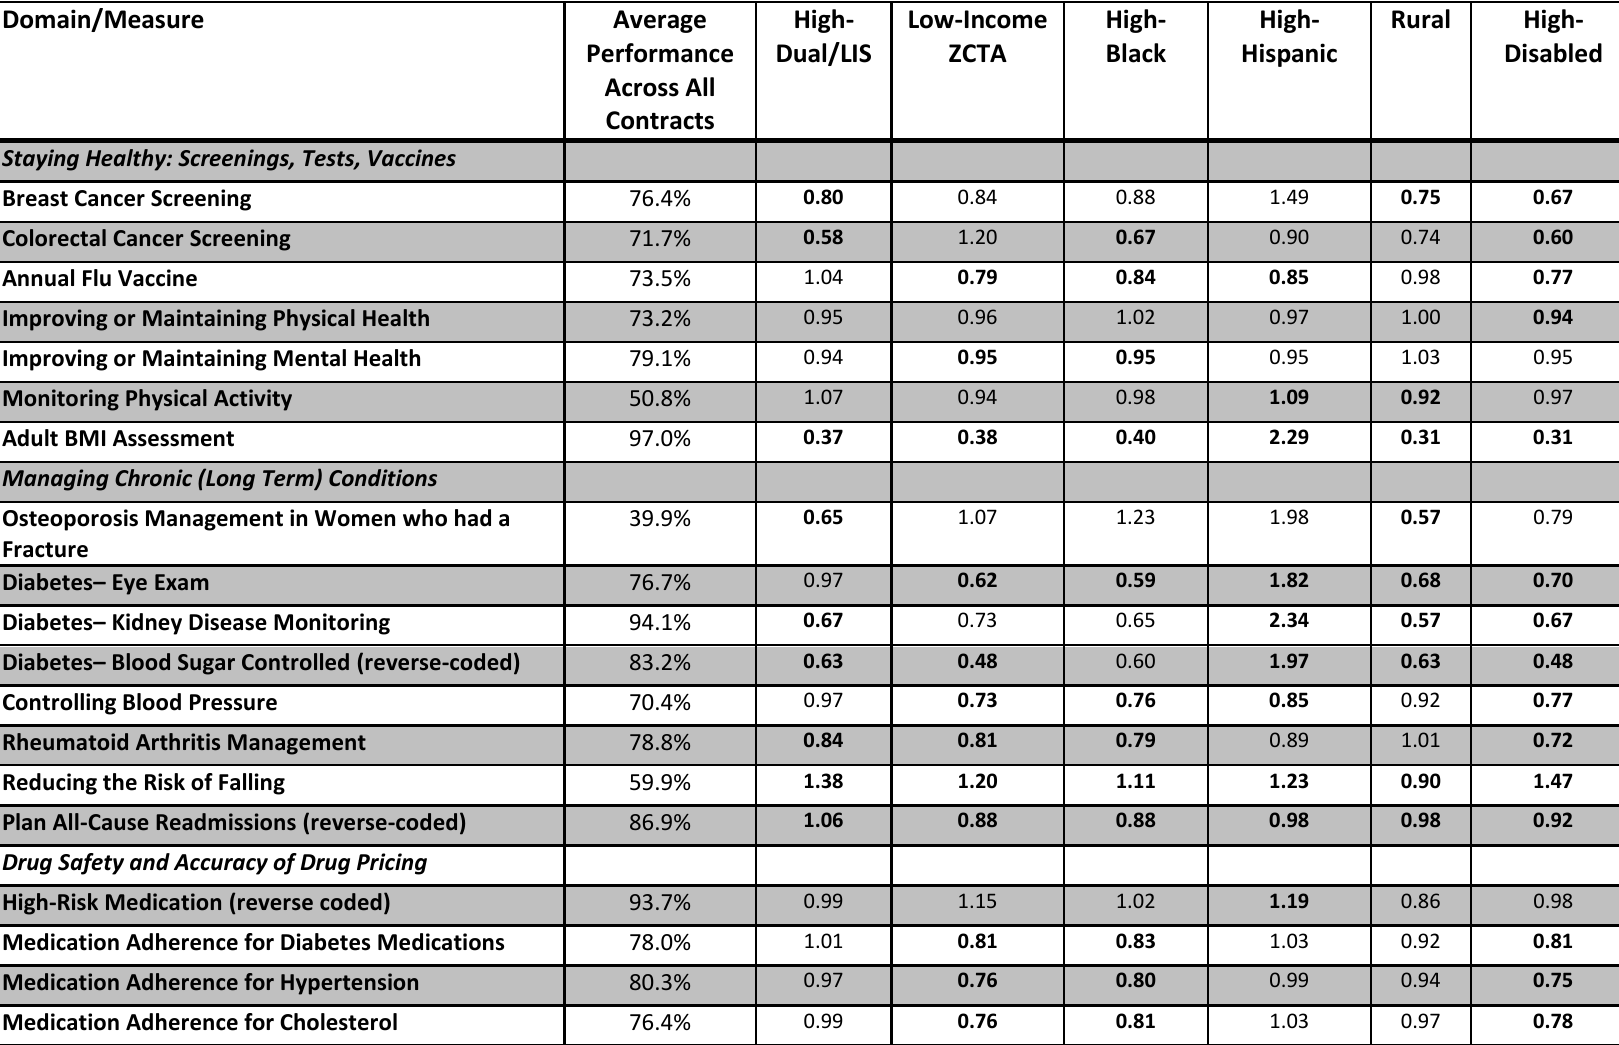
Table 8.4: Contract Social Risk and MA Beneficiary-Level Measure Performance, Odds of Successfully Attaining Measure, 2014